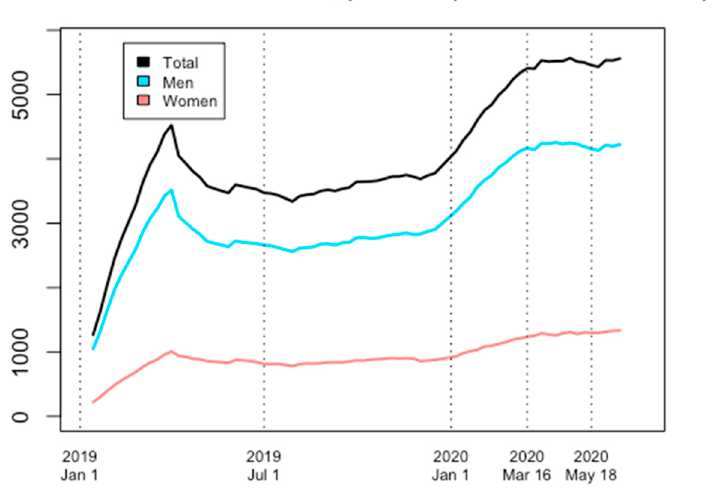
Figure 3. Number of self-excluded on every Monday, 1 January 2019 through 16 June 2020. Self- exclusions with a three-month duration.